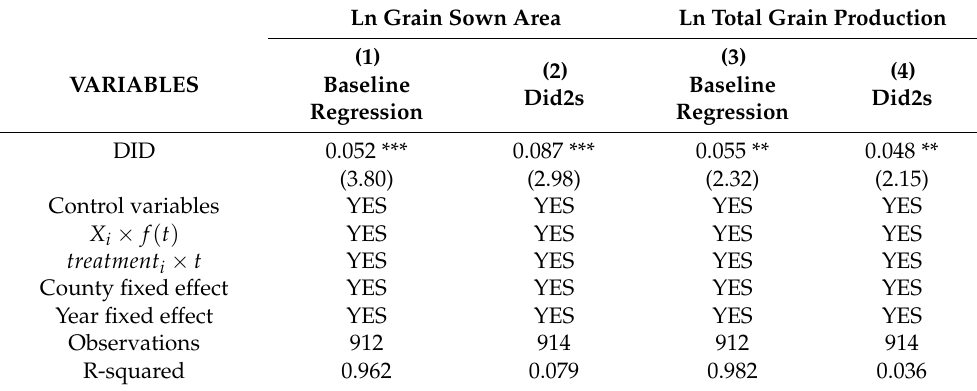
Table 6. Regression results when considering treatment of